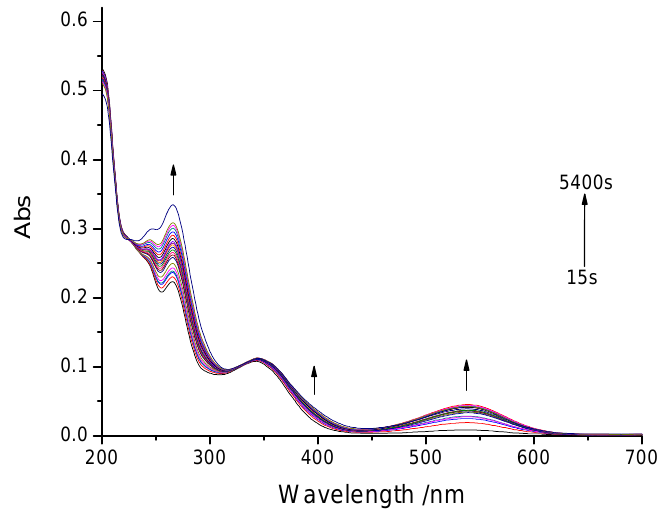
O = 6:4) upon irradiation 2